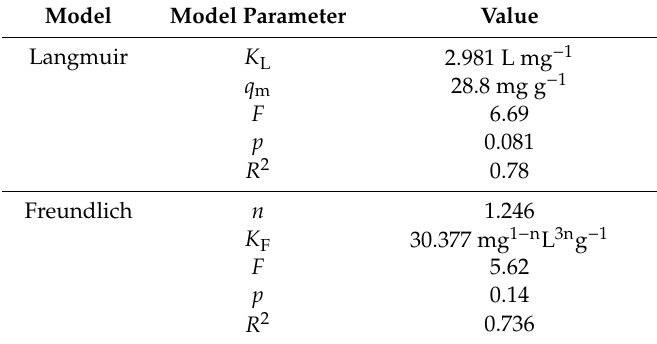
Table 6. Parameters of the Langmuir and Freundlich isotherm model, obtained for selenate adsorption by the ER / DETA / FO /